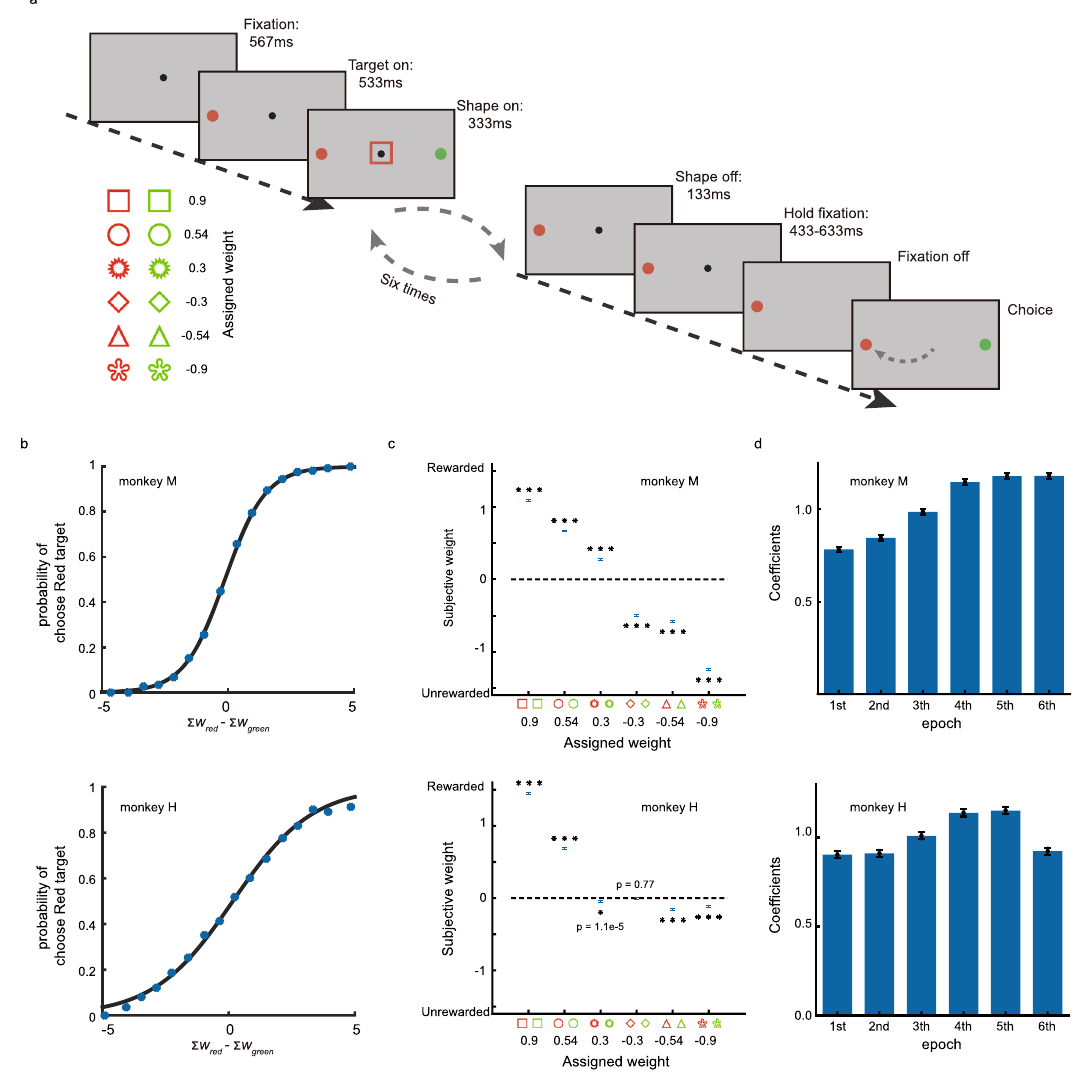
Fig. 1 | The task and the monkeys ’ performance.a The schematicdiagramof the probabilistic reasoning task. Targets are displayed in the periphery at 567ms after the fi xationacquisition.Afteranother533ms,sixstimuliarepresentedsequentially at the center. The stimuli are randomly selected from a pool of six shapes; each assignedwithaweight(bottomleft).Theshapescanbeeitherredorgreen,andthe reward probability of each target is determined by the total weights of the shapes withthesamecolor. b Psychometriccurve.Themonkeystended